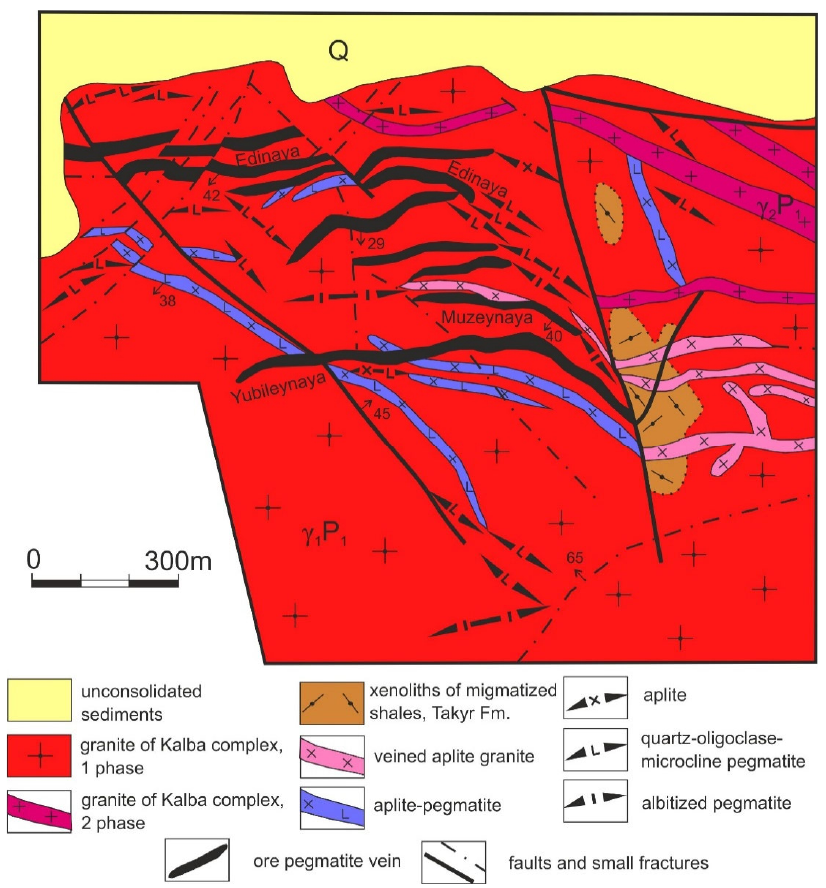
Figure 6. Geological sketch of the Yubileynoye pegmatite deposit (map view), after unpublished data of V.A. Filippov.